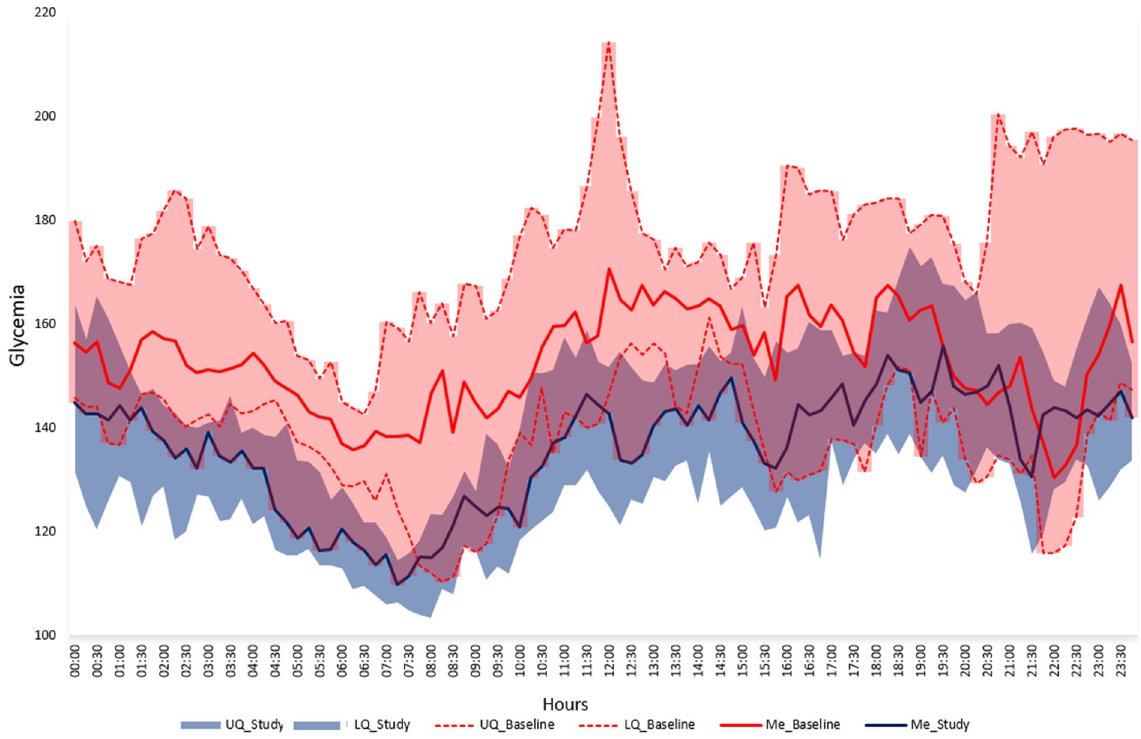
Fig 3. Median (IQR) glycemia in the last 4 weeks of the study period (blue area) and the baseline (pink area). UQ—upper quartile, LQ— lower quartile, Me—median.